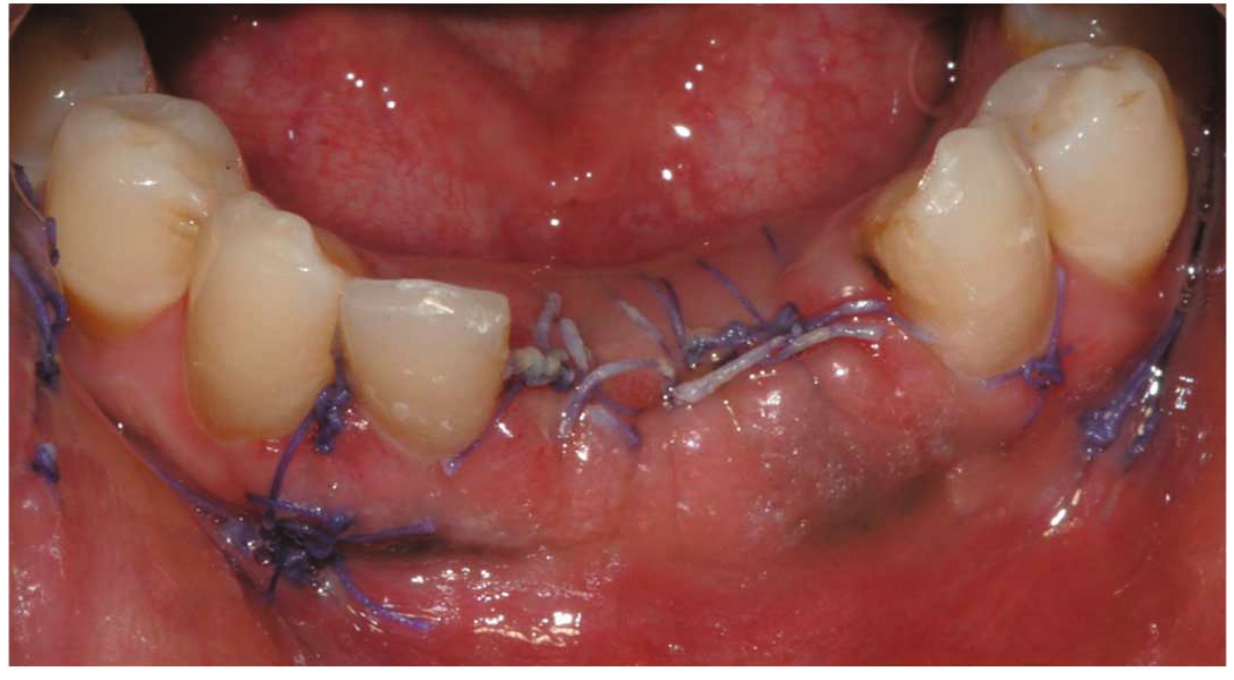
Figure 5: Clinical image after 14 days from the